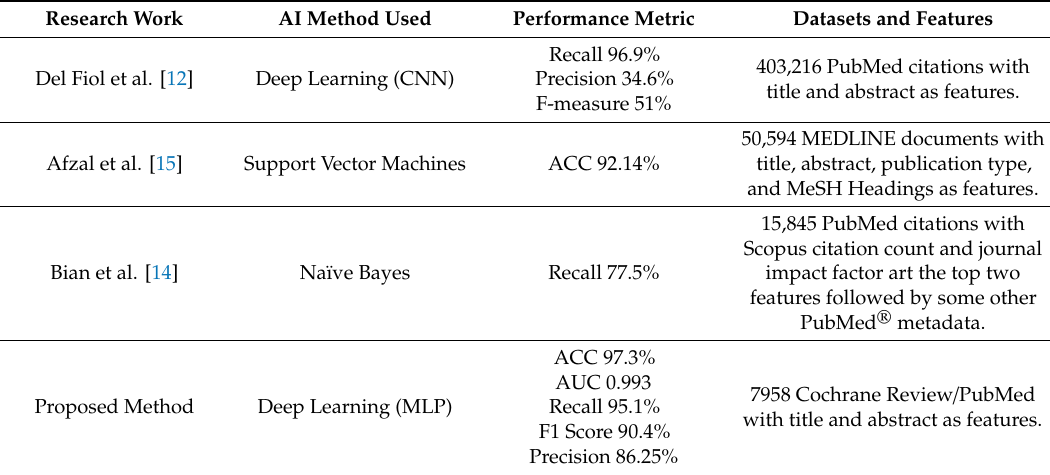
Table 7. Performance comparison of the proposed model and past